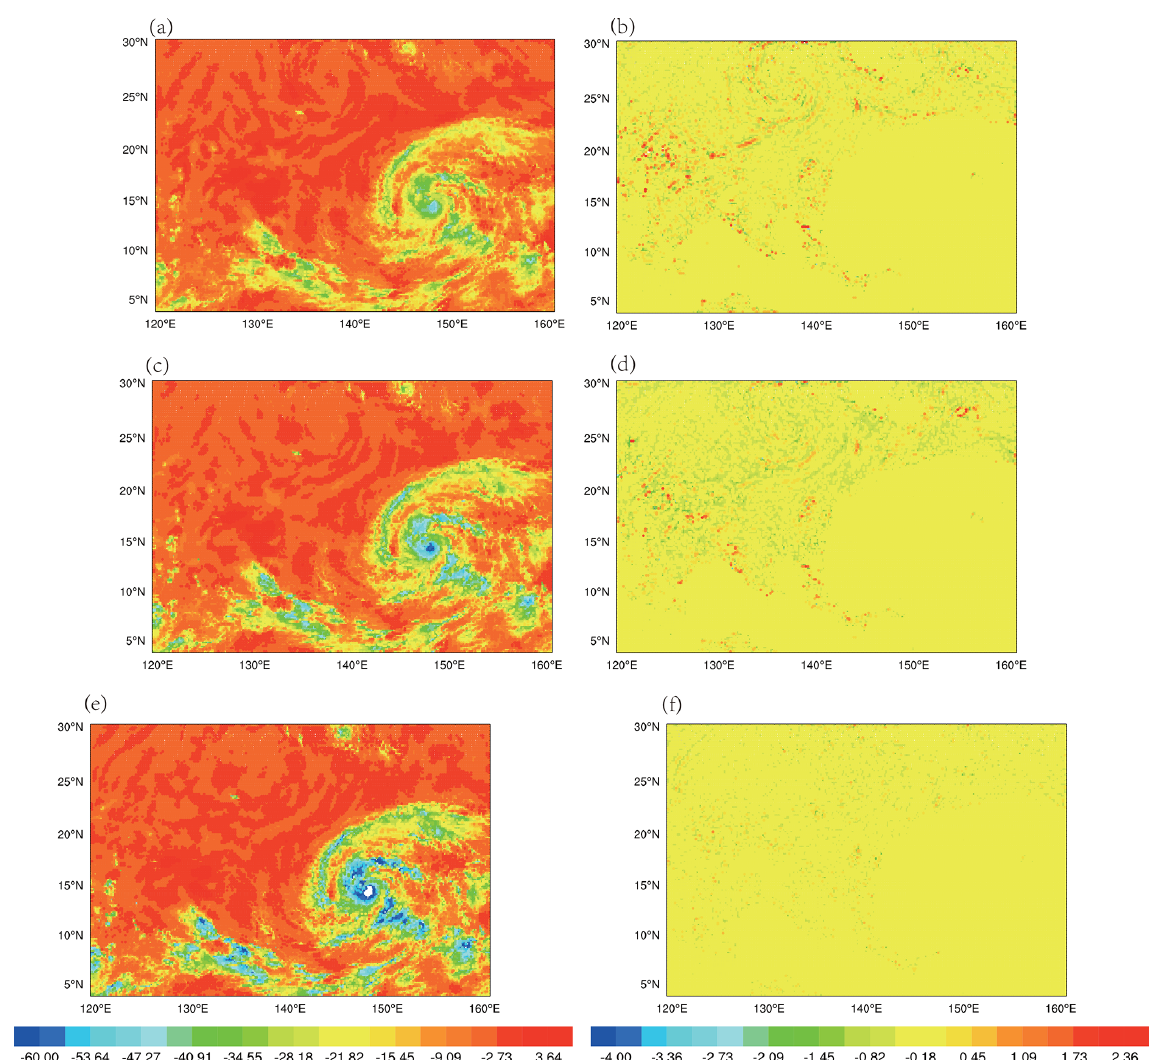
Figure 7. (a, c, e) OMB (unit: K) after bias correction for channels 8–10, respectively; (b, d, f) OMA (unit: K) after bias correction for channels 8–10, respectively, at 00:00UTC on 2 August